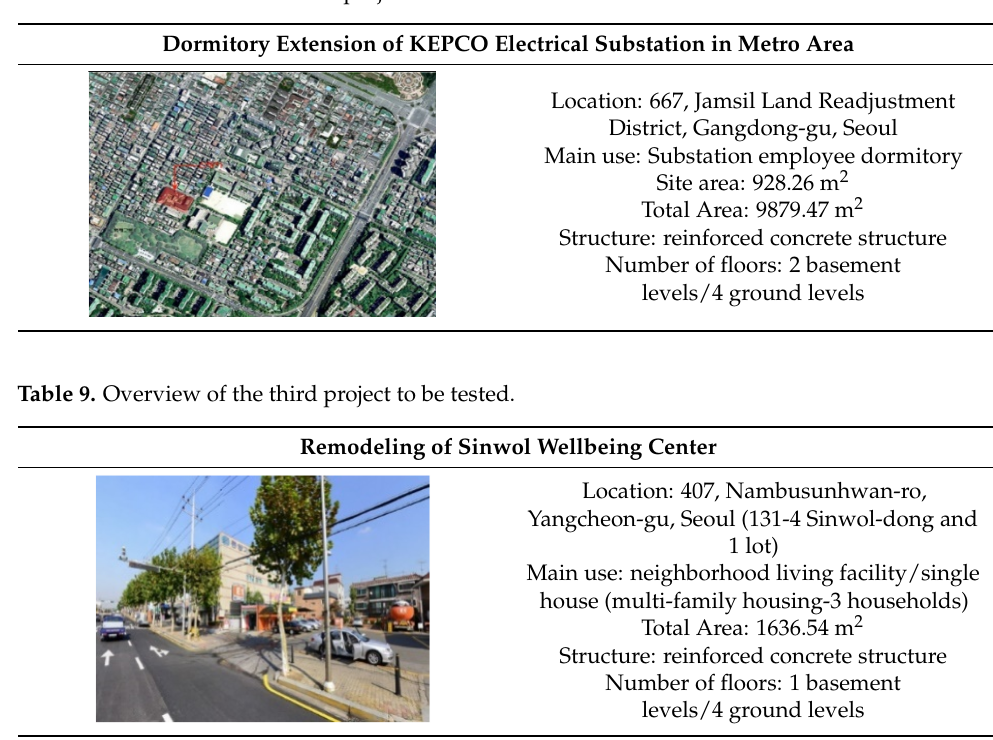
Table 8. Overview of the second project to be tested.